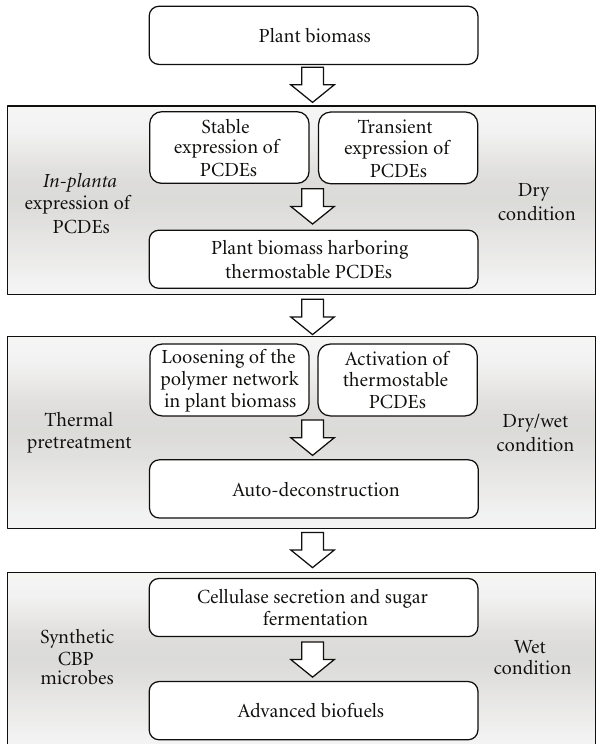
Figure 2: The combination of in-planta expression of PCDEs and synthetic CBP cellulolytic microbes can provide e ff ective production of cellulosic